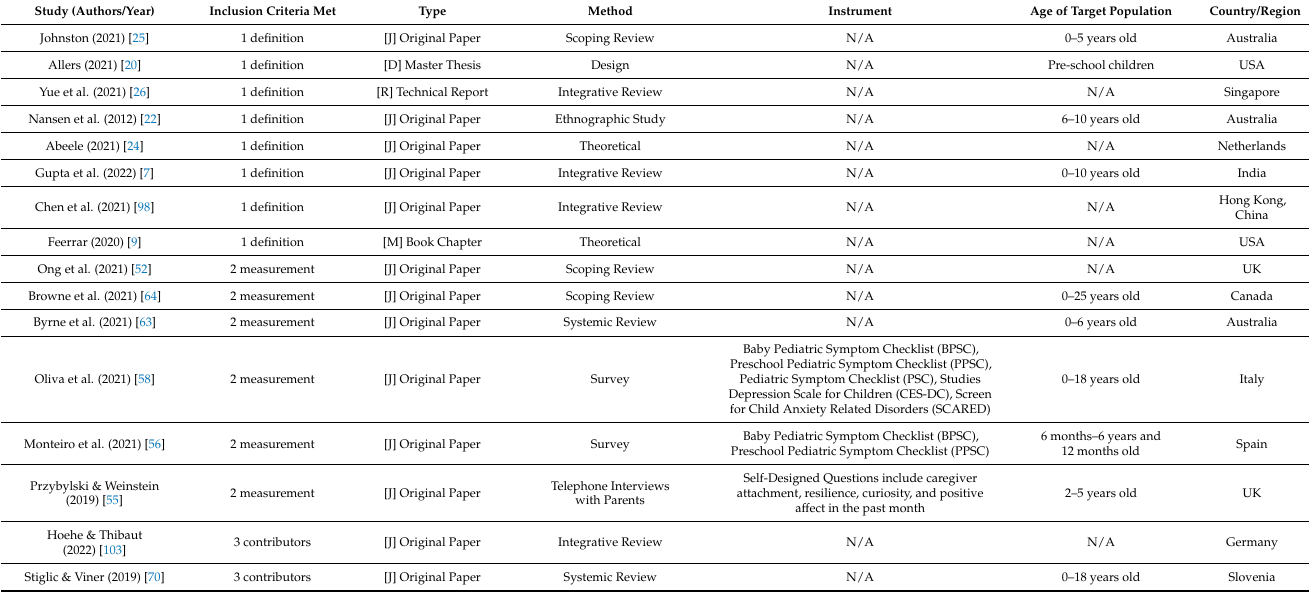
Table A1. Characteristics of the included